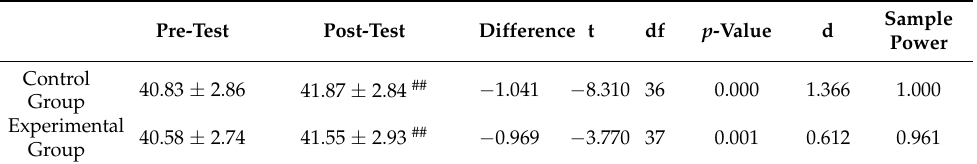
Table 11. Pre/post comparison of WHOQOL-26 for two